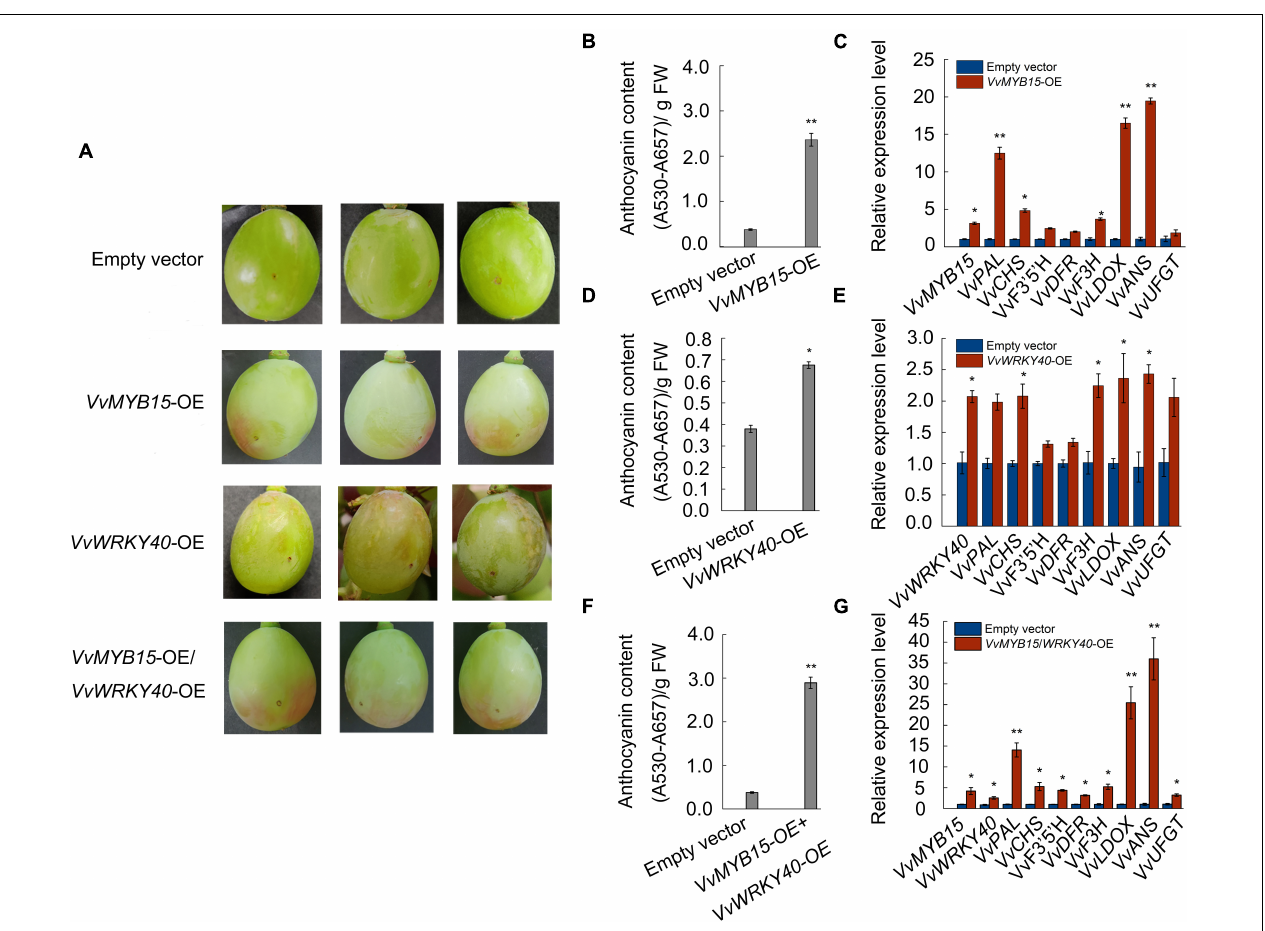
FIGURE 5 | Transient overexpression of VvMYB15 and VvWRKY40 promoted anthocyanin accumulation in grape berries, respectively. (A) Anthocyanin accumulation phenotypes at 5 days after injection and (B,D,F) relative anthocyanin contents of grape berries of transient transformed A. tumefaciens harboring 35S::GFP empty (Control), 35S::VvMYB15 - GFP , 35S::VvWRKY40 - GFP or 35S::VvMYB15 - GFP / 35S::VvWRKY40 - GFP , respectively. (C,E,G) Expression analysis of VvMYB15 , VvWRKY40 and anthocyanin biosynthesis-related genes ( VvPAL , VvCHS , VvF3 (cid:48) 5 (cid:48) H , VvDFR , VvF3H , VvLDOX , VvANS , and VvUFGT ) in grape berries were detected by qRT-PCR, Vvactin was used as internal control. Three biological replicates were performed, the error bars donate standard deviations. Asterisks represent different level of significance ( P ≤ 0.05*, P ≤ 0.01**), and significant differences is indicted by different lowercase letters based on independent sample t